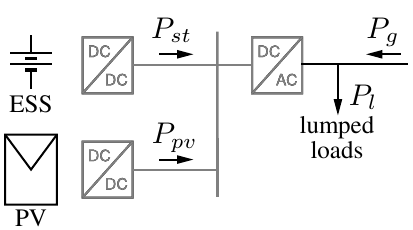
Figure 1. Schematic representation of the considered powers.